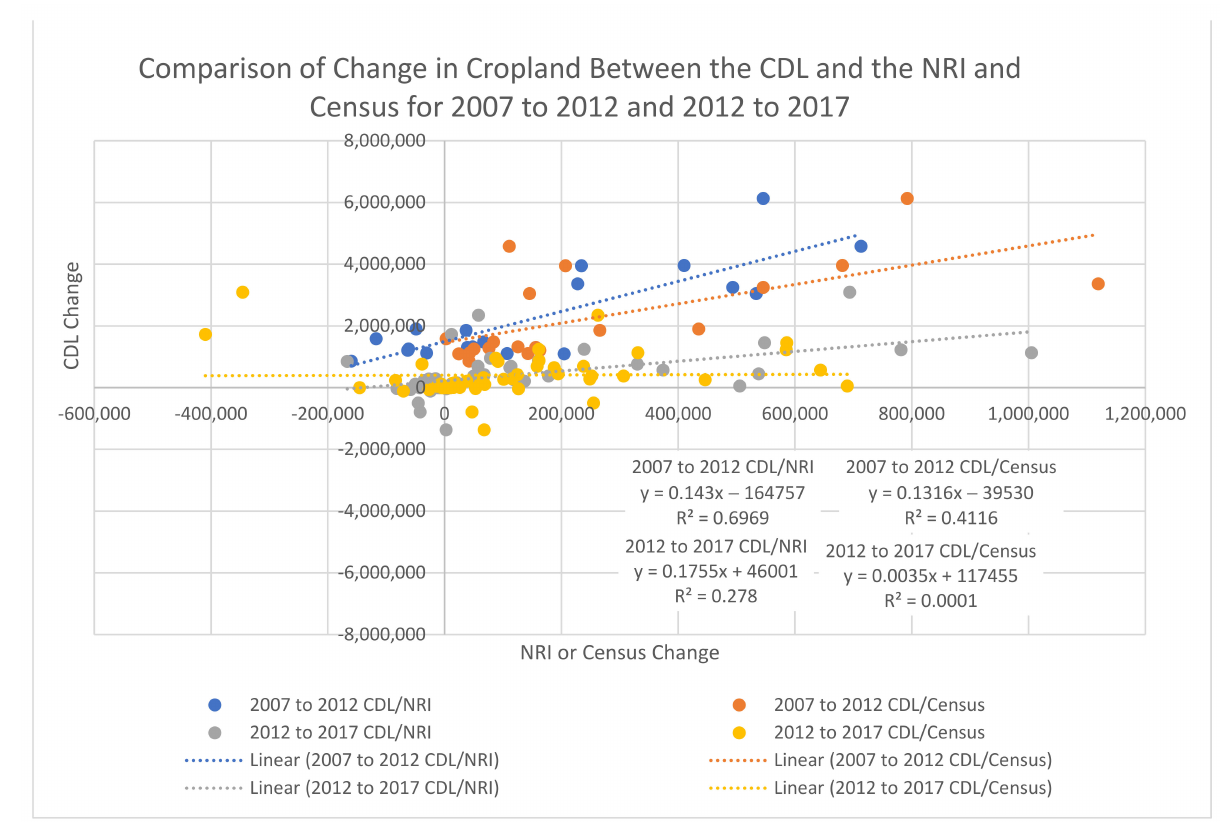
Figure 4. Relationships in total cropland change estimated using the CDL compared to the NRI and Census for the 2007 to 2012 and 2012 to